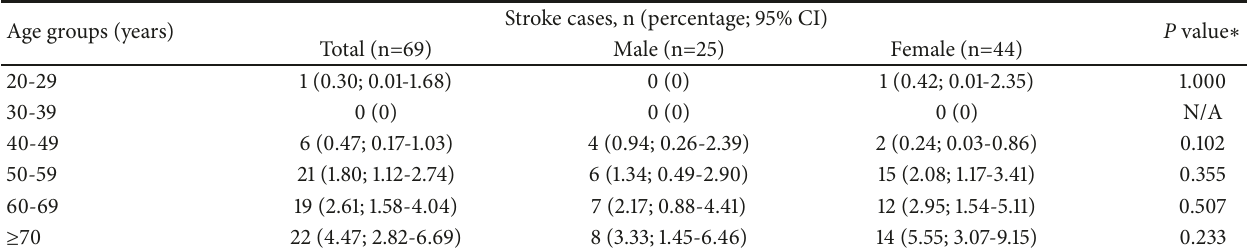
Table 2: Age- and gender-specific prevalence of stroke.